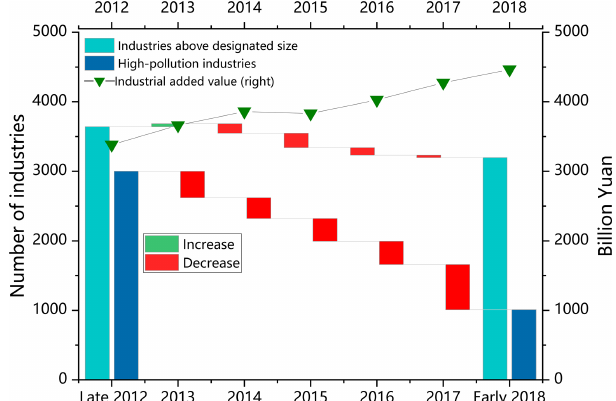
Figure 2. Quantities and variations of industries above a desig- nated size and high-pollution industries from late 2012 to early 2018 (bridge figure) and industrial added value from 2012 to 2018